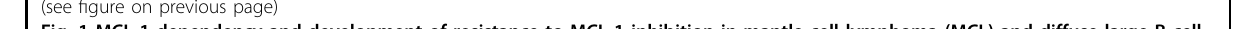
Fig. 1 MCL-1 dependency and development of resistance to MCL-1 inhibition in mantle cell lymphoma (MCL) and diffuse large B cell lymphoma (DLBCL). A Dose – response curves of MCL (top) and DLBCL (bottom) cell lines treated with S63845 for 72 h. Data are shown as mean ± SD, n = 3 technical replicates for each cell line. B Western blot analysis of BCL-2 protein expression in paired parental (P) and S63845-resistant (MR) cell lines. Band density was quanti fi ed and each MR cell line was normalized to its parental cell line. C Image-based cell-viability assays of MR cells with and without BCL-2 knockdown in response to S63845 (top: 10 μ M, bottom: 1.11 μ M). Inset: western blot con fi rming BCL-2 knockdown in each MR cell line. D Gene set enrichment analysis (GSEA) enrichment score plots of selected pathways from KEGG (C2) and Oncogenic Signatures (C6) gene sets from MSigDB. Genes were ranked according to their gene expression fold change between SUDHL-16 MR and parental cells. NES normalized enrichment score, FDRq false discovery rate adjusted p value. E Kinome tree representation of kinases with activity signi fi cantly upregulated in SUDHL-16 MR cells compared to parental cells. Upregulated kinases de fi ned as having fold change of 1.5. Labeled kinases belong to the BCR, MEK – MAPK, and PI3K – AKT/mTOR pathways. F Western blot analysis of paired parental, and MR cells. p-ERK phosphorylated ERK, t-ERK total ERK. Band density was quanti fi ed for each protein and each MR cell line was normalized to its parental cell line. Data shown in A , B , and F are representative of at least three independent